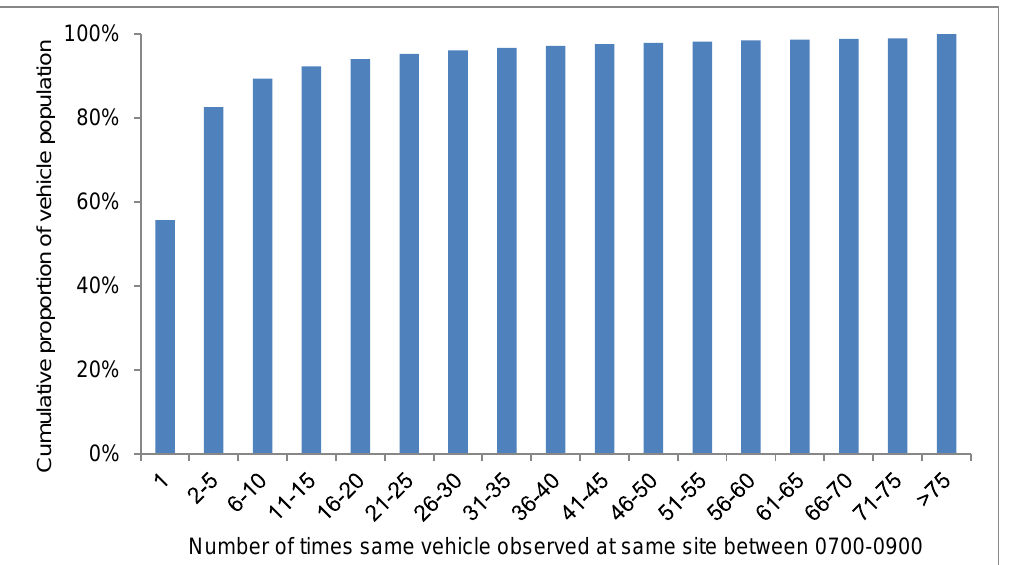
Figure 4. Cumulative frequency averaged across all sites of individual vehicle observations in 210-day period during morning peak (0700-0900) Table 2. Proportions of one-off observations of plates at each